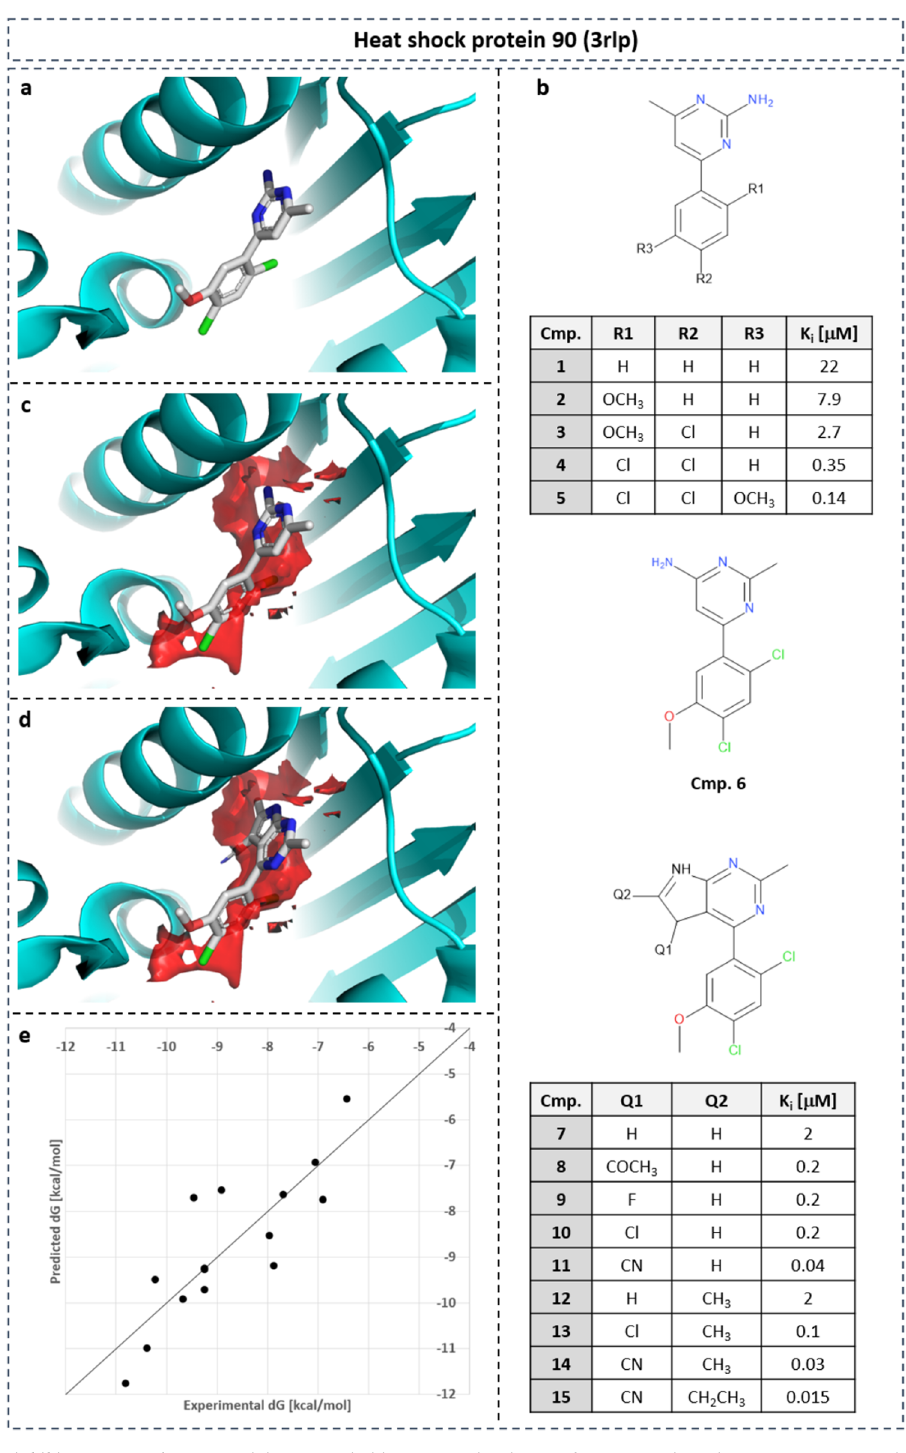
Fig. 11 SAR of HSP90 inhibitors. SAR of HSP90 inhibitors guided by gain in desolvation free energy based on point-wise neural-network model. a Co- crystalized compound 5 in PDB structure with ID 3rlp. b SAR table of 15 inhibitors with substituents replacing water density with unfavorable free energy (c/d: isolevel: 7.5 kcal mol − 1 ). d Compound 8 from X-ray structure 3rlr. e Linear regression between predicted desolvation and experimental binding free energy for SAR series ( r 2 = distributed on a 3D grid that encompasses the binding site and is used as output protocol combining 3D-RISM, GAsol, and WATsite (Fig. 15) was used to achieve layers for the neural networks to be trained on. Details on WATsite simulations convergence for hydration-site occupancy and thermodynamics predictions for and analysis can be found in the Supplementary Methods section. solvent-exposed and occluded binding sites 20 . Using 3D-RISM site-distribution function 49 – 51 and GAsol 42 for initial placement of water molecules, WATsite then performs explicit water MD simulations of each protein. Finally, explicit water occupancy and free energy pro fi les of each hydration site (i.e., high water- occupancy spot) in the binding site are computed. This hydration data is